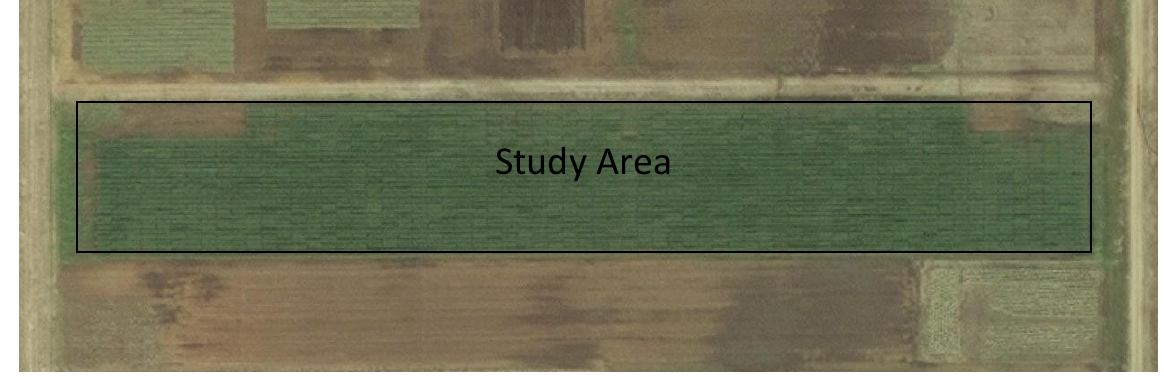
Figure 3. Aerial imagery of Dupy wheat experiment.